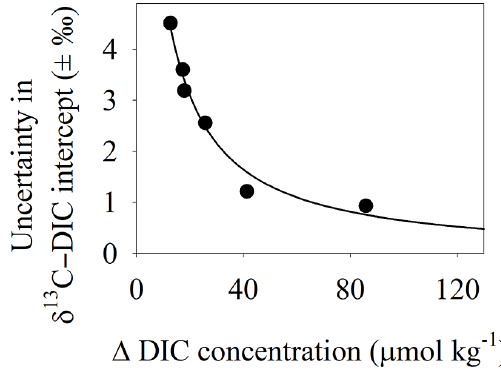
Figure 5. Relationship between Keeling intercept uncertainty and changes in DIC concentration. Higher changes in DIC resulted in lower uncertainties in Keeling plot